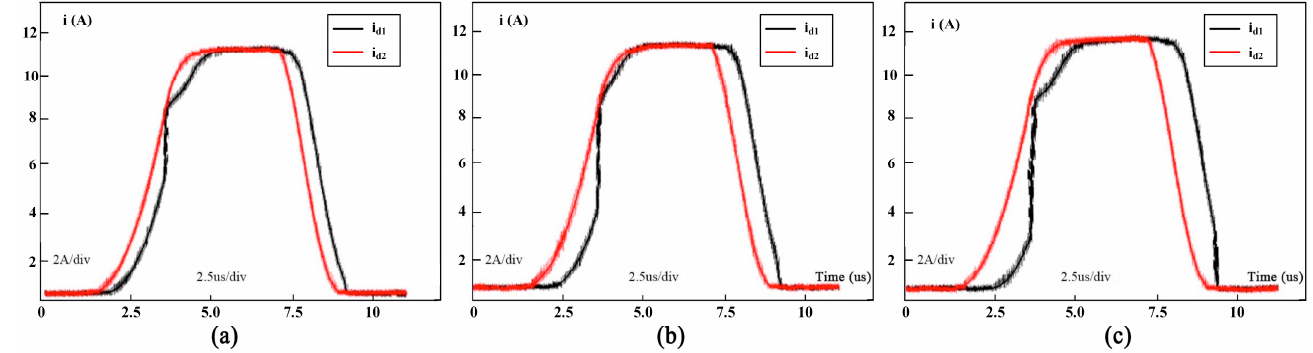
Figure 17. Double-pulse simulations with multiple parasitic inductance parameters: ( a ) L g within the switching process; ( b ) L d within the switching process; and ( c ) L s within the switching process.